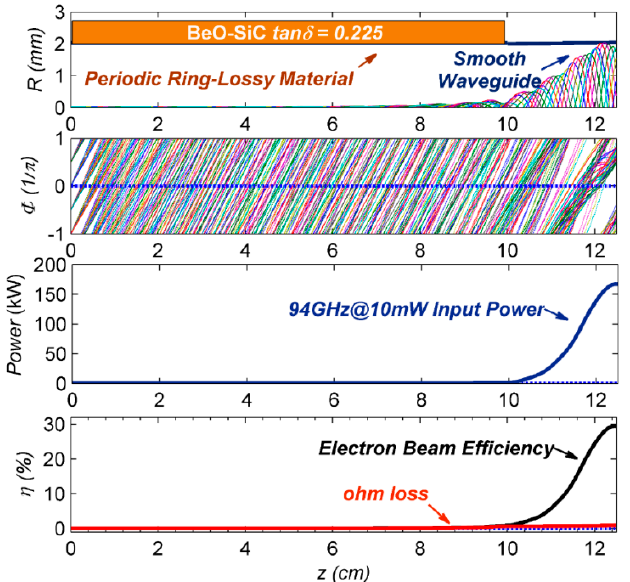
Figure 5. Process of the beam–wave interaction in the designed interaction region ( f = 94 GHz, drive power is 10 mW, velocity spread is 5%).